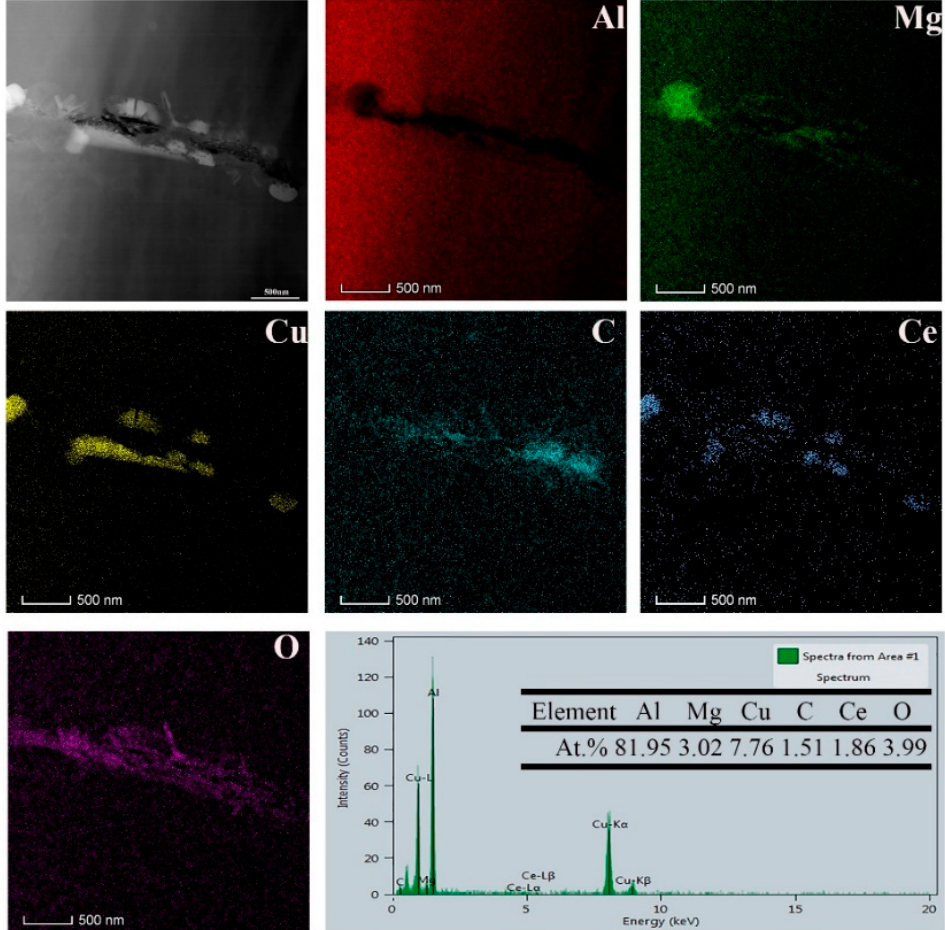
Figure 7. Mapping analysis of the 0.5 wt.% GNPs/2024Al composite fabricated.